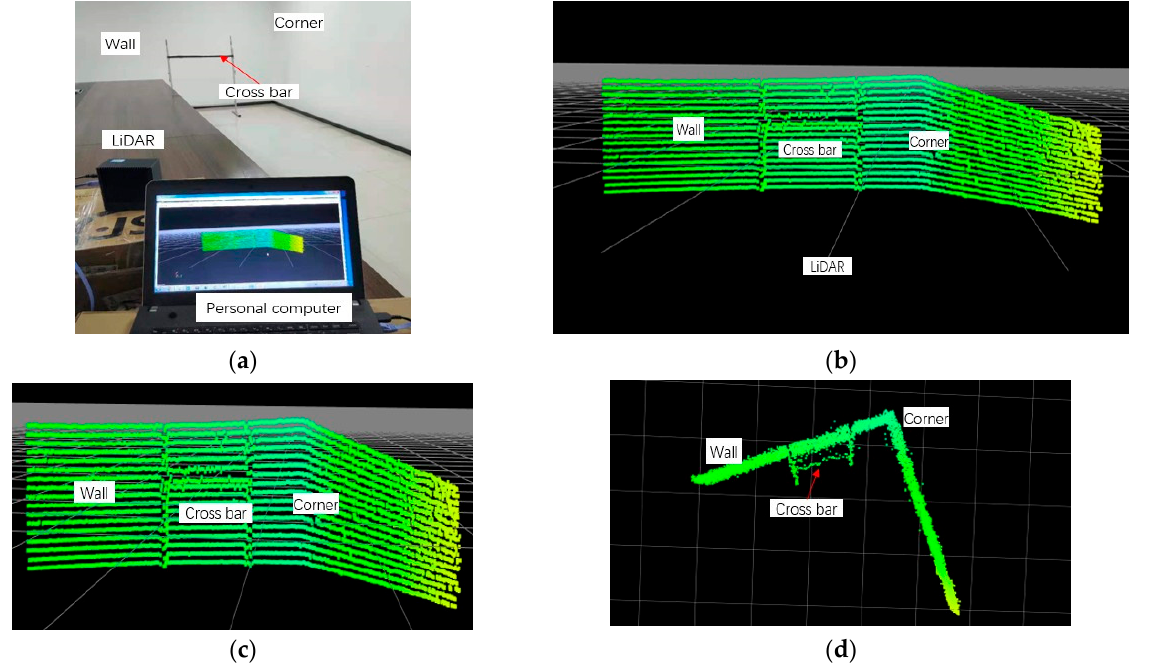
Figure 4. ( a ) Picture of the experiment of the angular resolution of 0.2° × 0.62°, ( b ) panorama of the cloud point, ( c ) front view, and ( d ) top view.